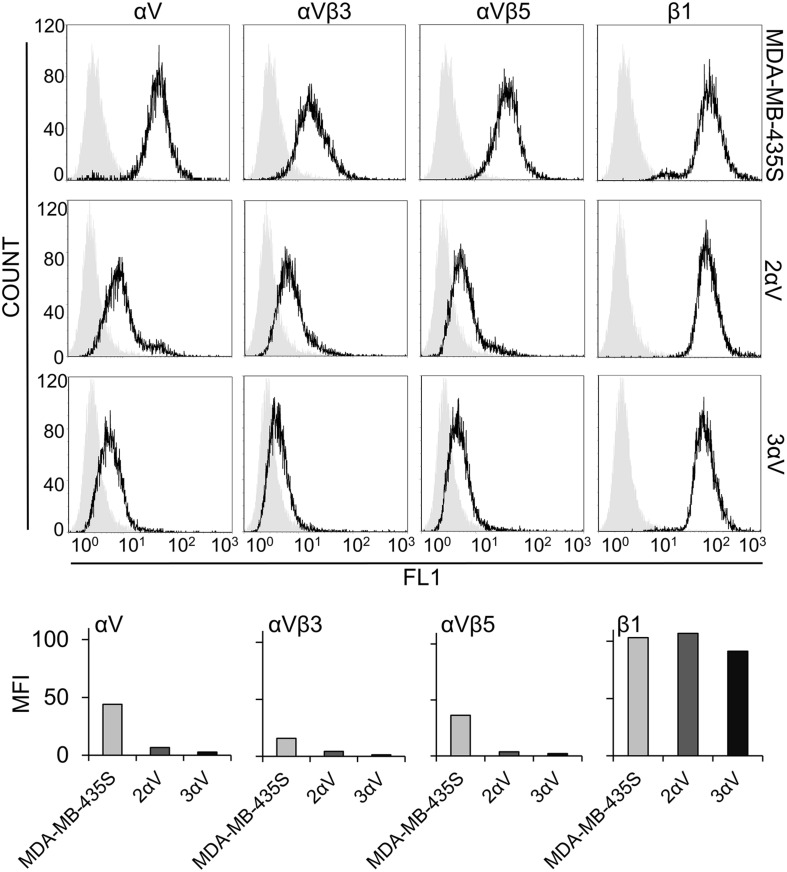
Characterization of the MDA-MB-435S cell model. Surface expression of integrin subunit αV, integrin heterodimers αVβ3 and αVβ5, and integrin subunit β1 in melanoma cell line MDA-MB-435S and clones 2αV and 3αV obtained by stable transfection with integrin αV-specific shRNA. Cells were detached by EDTA and analyzed by flow cytometry upon incubation with antibodies against integrin subunit αV, β1, or integrin heterodimers αVβ3 or αVβ5 (black histogram), and isotype-matched antibody as a negative control (gray histogram), followed by rabbit FITC-conjugated-anti-mouse antibody (upper panel). Results from upper panel were presented as comparisons of MFIs within the cell model (lower panel). Representative data of three independent experiments yielding similar results are shown.